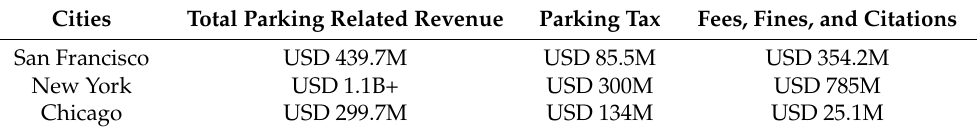
Table 2. Municipalities budget from parking-related revenues (in United States Dollars, 2019–2020 fiscal year).